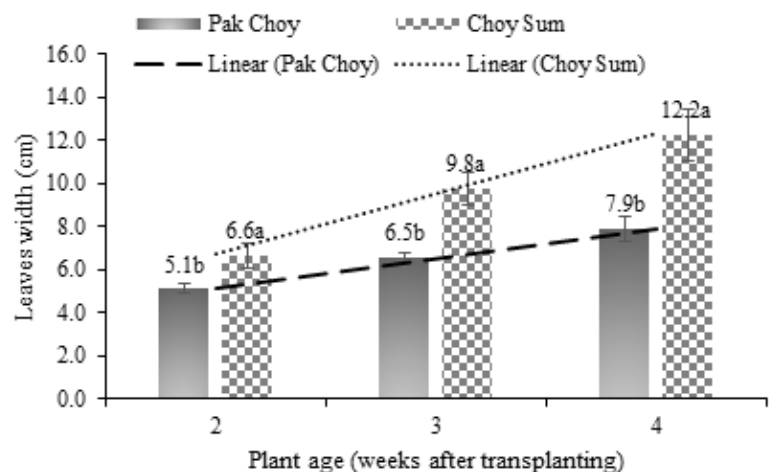
Figure 3 Leaves width on 2 subspecies Brassica during plant growth. Values followed by the same letter in the same age are not significantly different (p < 0.05) by Duncan's multiple range test at